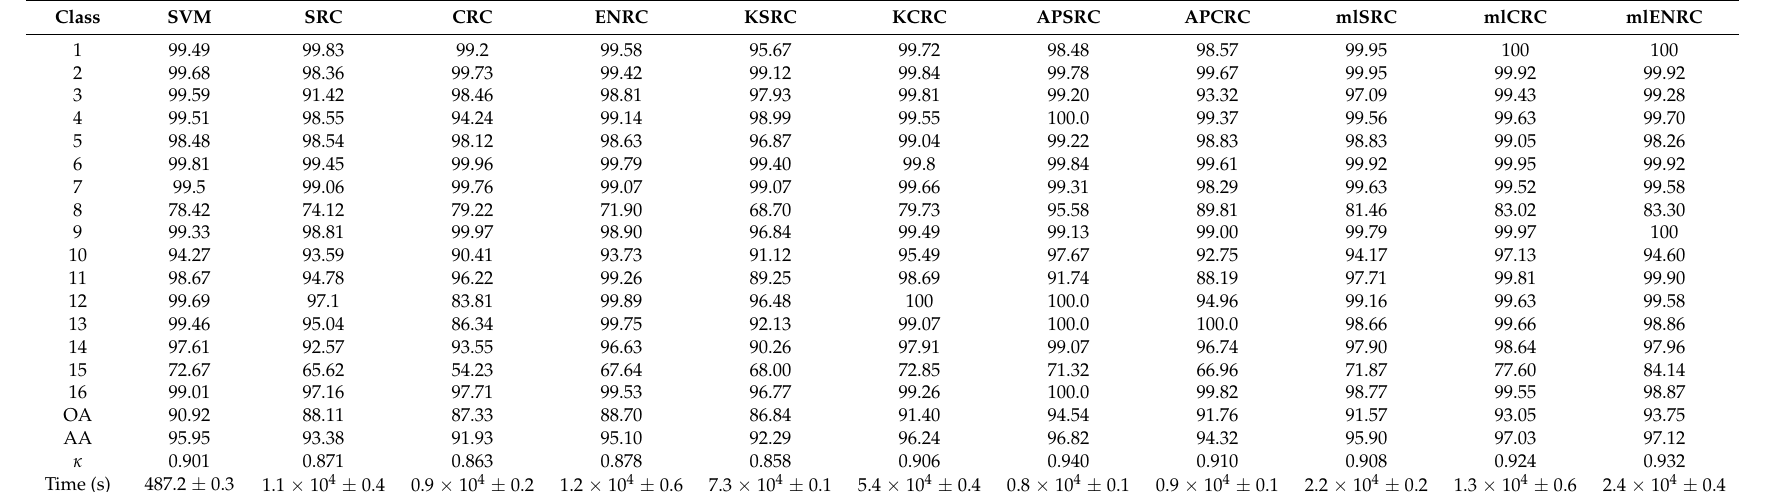
Table 8. Class-specific accuracy (%), overall (OA), average (AA), kappa ( κ ), as well as computational time in seconds with 120 training samples per class for the Salinas